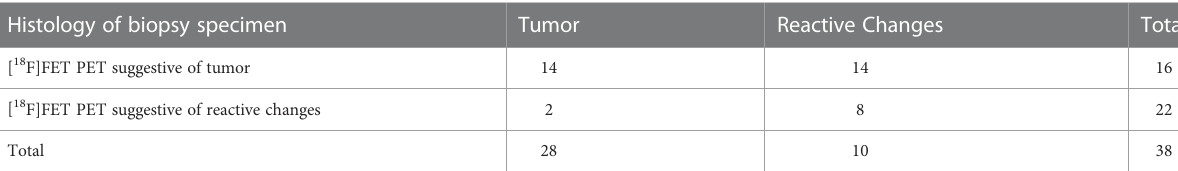
TABLE 3 Results of [ 18 F] FET PET and stereotactic biopsy in suspected